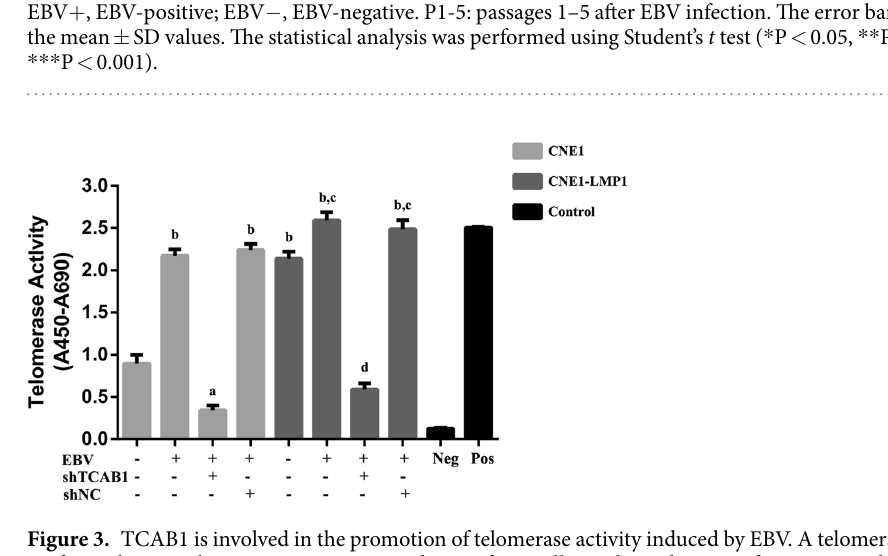
we examined the expression of ATR, the function of which is to regulate the repair of damaged DNA replication forks. As shown in Fig. 6E, the levels of phospho (p)ATR increased after EBV infection. As a reliable marker of ATR activation 24, 25 , phosphorylation at S33 of the 32-kDa subunit of replication protein A (RPA32) was also detected following EBV infection. In contrast, after selection with puromycin, only small amounts of pATR and pRPA32 were detected in CNE1 cells treated with shTCAB1 lentivirus. As expected, the level of the critical check- point kinase Chk1, the downstream target of ATR that is critical for checkpoint activation upon DNA damage, was also reduced after TCAB1 depletion. These results indicate that TCAB1 is involved in ATR activation induced by EBV in response to replication stress-associated DNA damage.